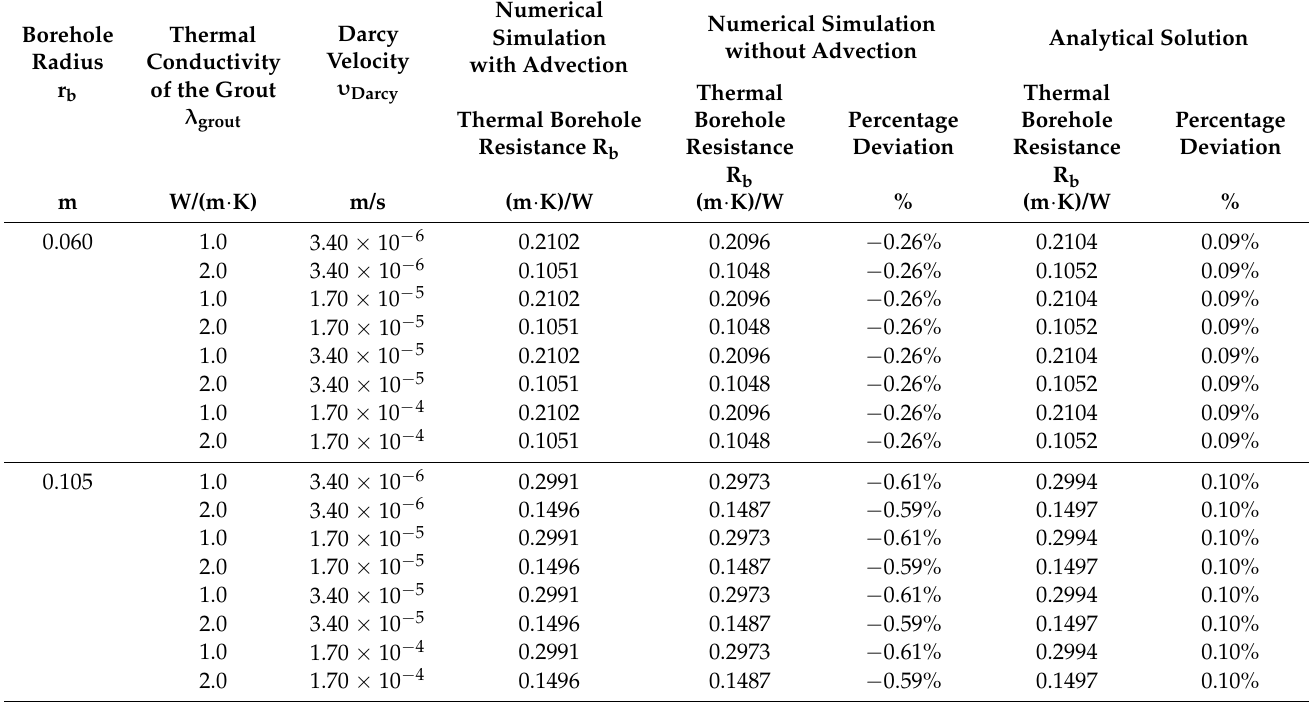
Table 2. Comparison of thermal borehole resistance calculations by numerical and analytical models. Borehole Radius r